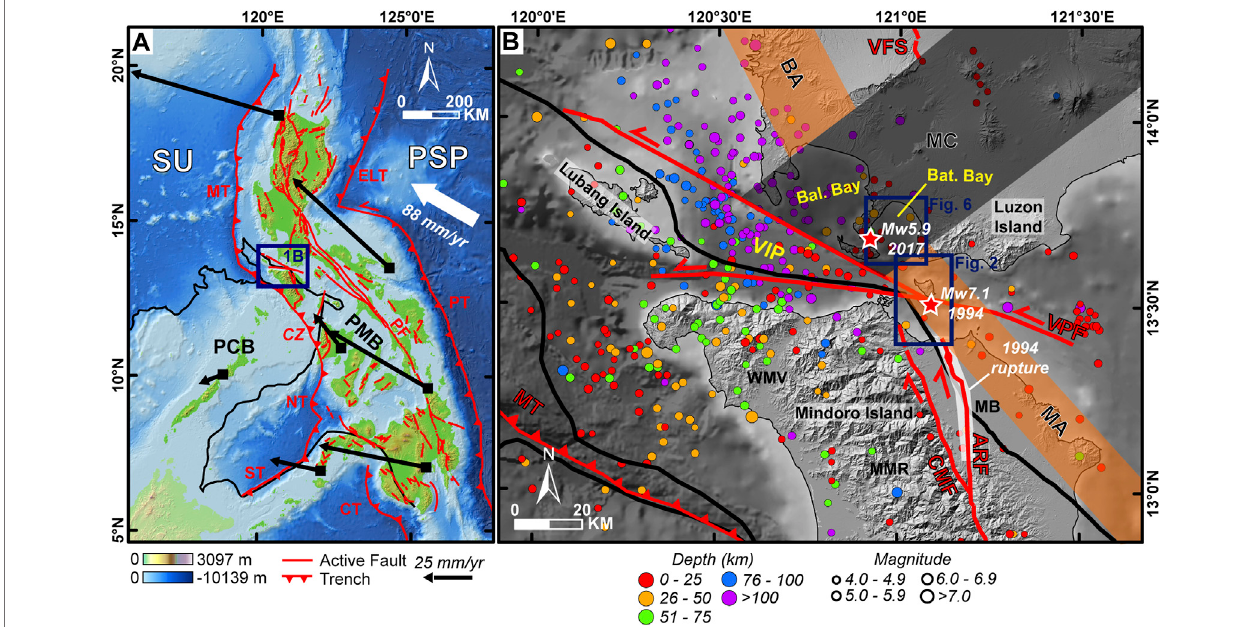
Quick Response Team (1994). Active faults in the region are the Verde Passage Fault (VPF), Aglubang River Fault (ARF), Central Mindoro Fault (CMF), and Valley Fault System (VFS). The volcanic regions in southern Luzon are the Macolod Corridor (MC), shaded in black, and the Southern Luzon Arc: Bataan Arc segment (BA) and Mindoro Arc segment (MA), both shaded in orange (Defant et al., 1991; Pubellier et al., 2000). Physiographic areas in northern Mindoro Island are the Mindoro Basin (MB), Mindoro Mountain Range (MMR), and Wawa-Mamburao Valley (WMV). Water bodies in between Mindoro Island and Luzon Island are the Verde Island Passage (VIP), Balayan (Bal.) Bay, and Batangas (Bat.) Bay. Topography is from ALOS World 3D – 30 m (AW3D30) DEM while bathymetry is from the GEBCO_2020